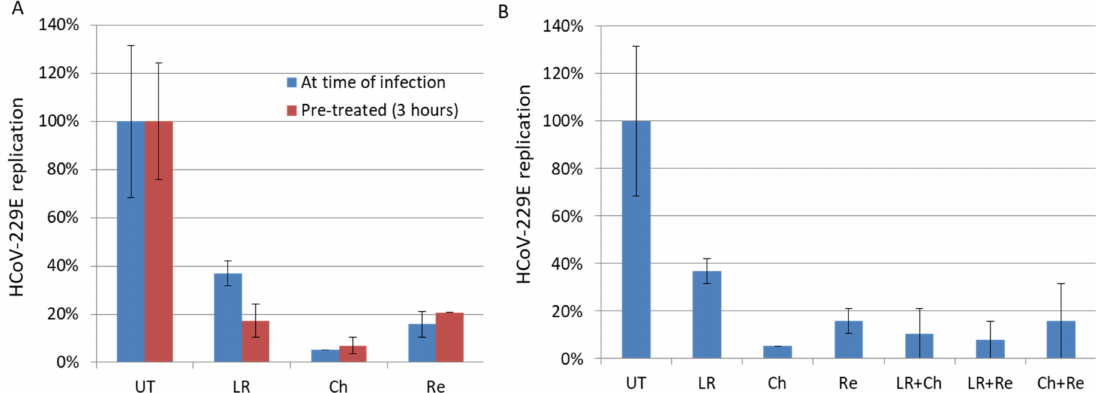
Figure 2. Inhibition of replication of low HCoV-229E viral load (0.01 MOI) by drugs. ( A ) No pretreatment (Blue) or 3-h pretreatment of cells (Red). ( B ) Combination of drugs. The cells were treated with Lopinavir/Ritonavir (LR), Chloroquine (Ch), Resveratrol (Re) or left untreated (UT) for 48 h. The viral replication was measured by PFU